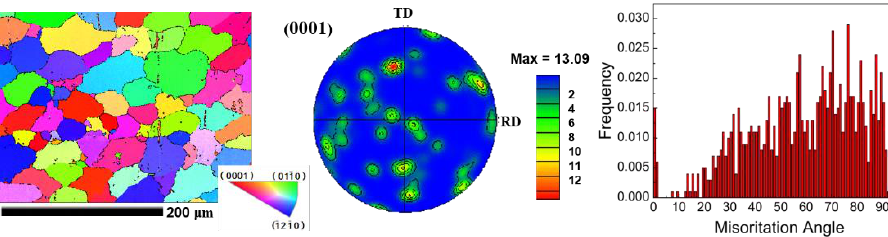
Figure 6. Initial plate EBSD-measured IPF maps, (0001) PFs, and misorientation-angle